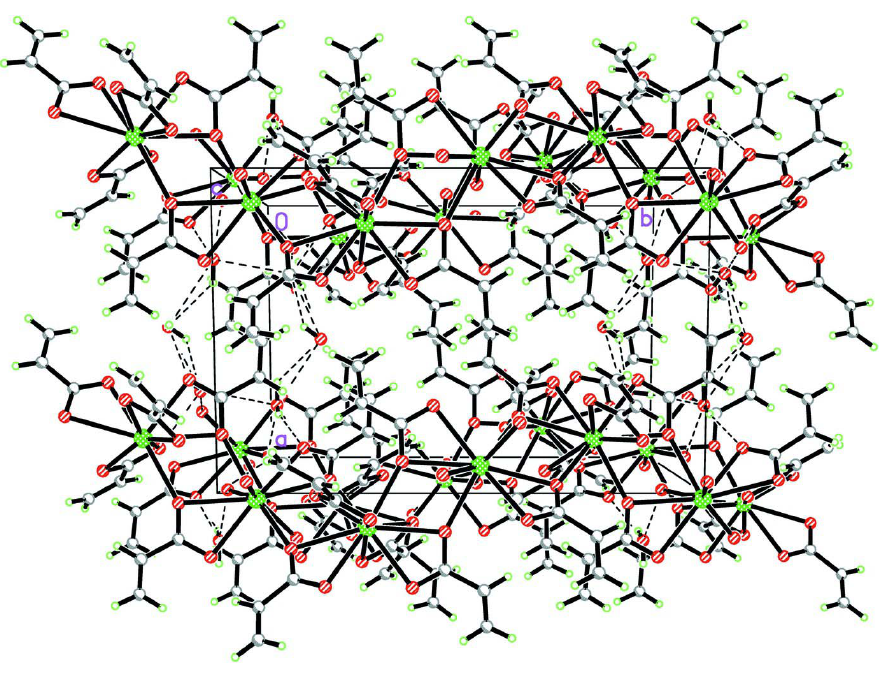
Figure 3 View of the packing of the title compound. catena-Poly[[[diacrylato- κ 4 O,O ′ -neodymium(III)]-di- µ - acrylato- κ 3 O,O ′ :O ′ ; κ 3 O:O,O ′